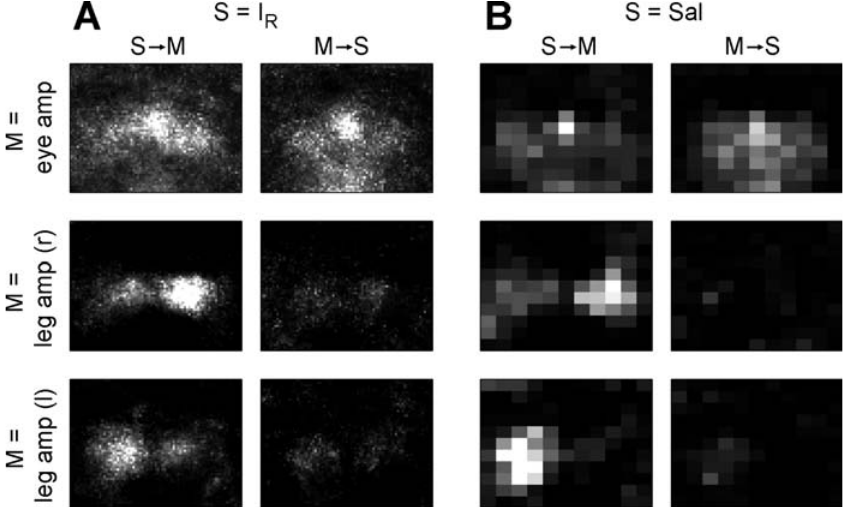
Figure 4. Information Flow (Transfer Entropy) in Strider Data is shown as z-score maps, plotted between z ¼ 0 and z ¼ 6, for a variety of sensory and motor variables. The z-scores are expressed as number of standard deviations above background, calculated as for Figure 3. (A) Transfer entropy between S ¼ red intensity map I R (55 3 77), and M ¼ eye (pan-tilt) amplitude (top), M ¼ right-leg amplitude (middle), and M ¼ left- leg amplitude (bottom). (B) Transfer entropy for S ¼ downsampled saliency map Sal (11 3 11). M variables correspond to those in (A). DOI: